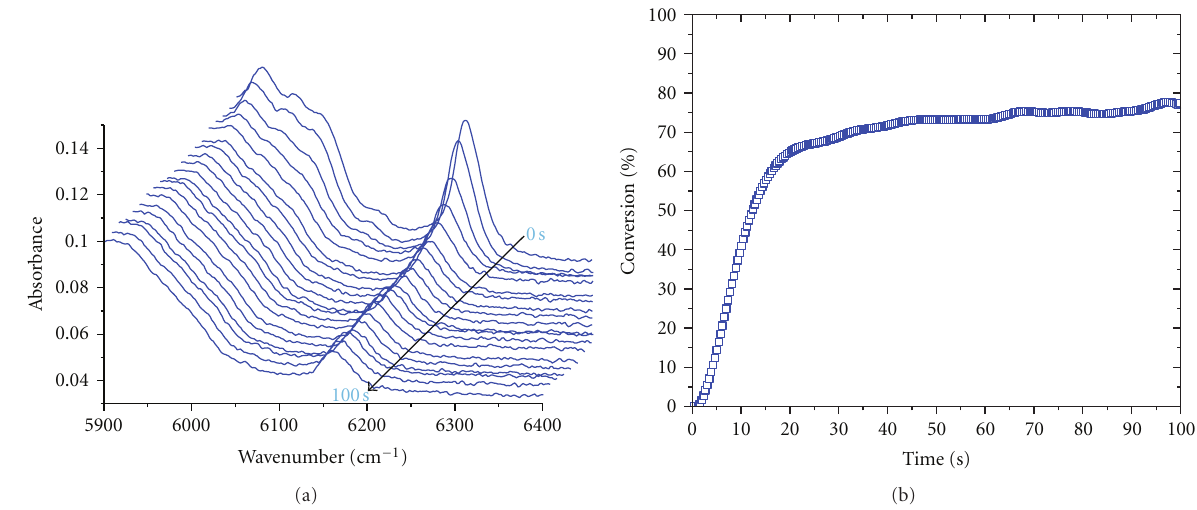
Figure 2: (a) Real-time IR peak area change and (b) C = C bonds conversion.